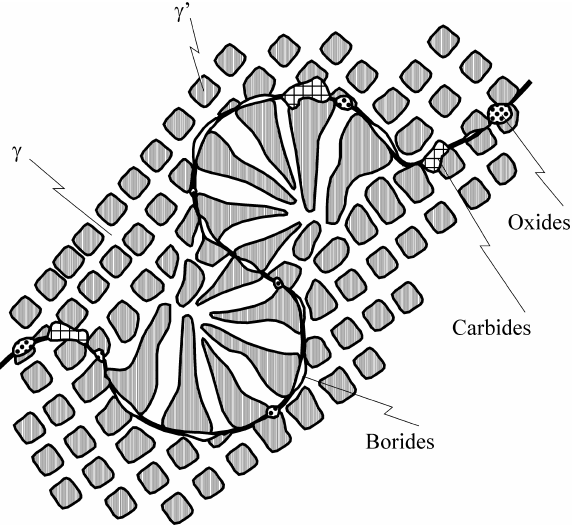
Figure 3. A microstructure for a γ / γ ’ superalloy with oxides, borides and carbides at the grain boundaries has a very long feature